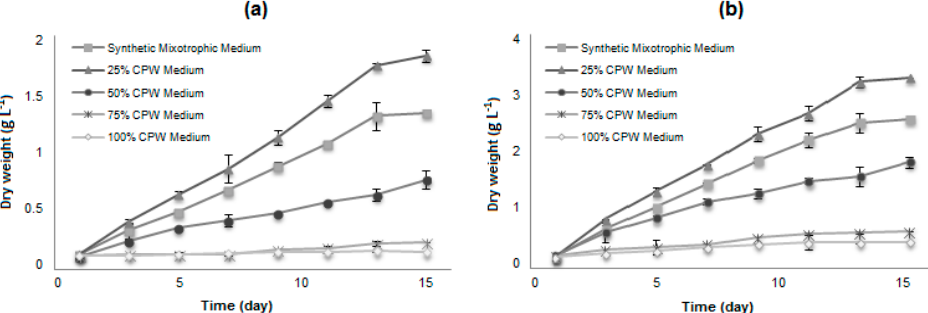
Figure 1. Dry cell weight of microalgae in a synthetic mixotrophic medium and different concentrations of CPW (25, 50, 75, and 100%): ( a ) H. pluvialis and ( b ) N. oleoabundans . Data are averages ± standard error.